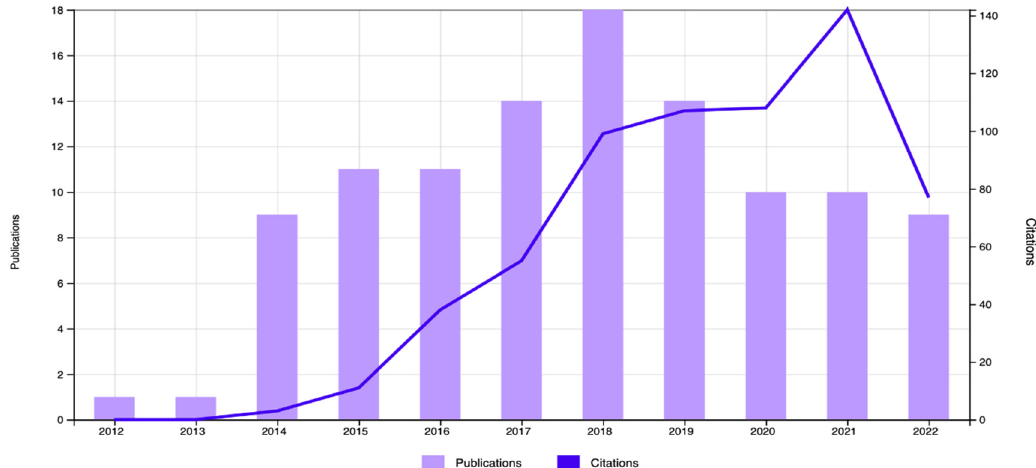
Figure 2. Number of publications and citations per year (2012–2022).